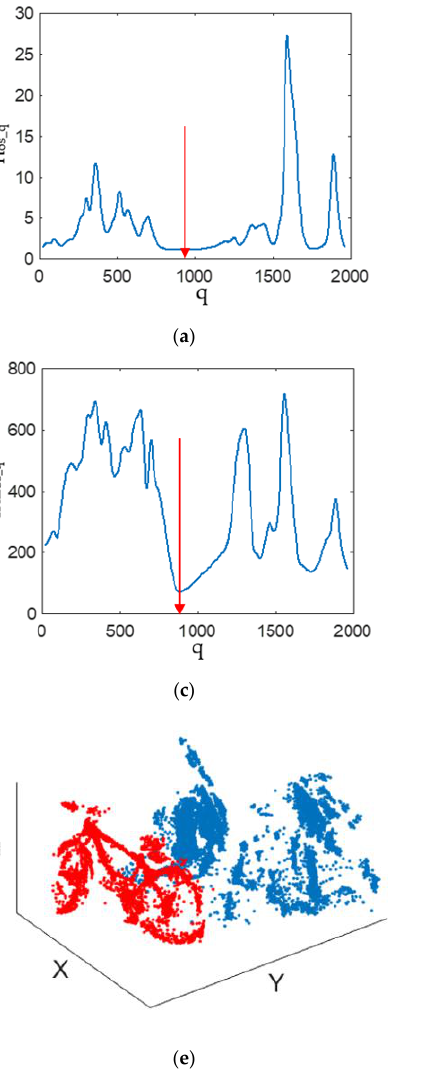
Figure 17. Truncating results for the 3D bike point cloud of Figure 13a: ( a ) the input curve of 𝑦 𝑜𝑠_𝑞 ; ( b ) the input curve of 𝑛 𝑜𝑠_𝑞 ; ( c ) the input curve of 𝑑𝑛 𝑜𝑠_𝑞 ; ( d ) the output curve of 𝑚𝑧 𝑜𝑠_𝑞 ; ( e ) the side view of the bike segmentation result; ( f ) the bird view of the bike segmentation result.